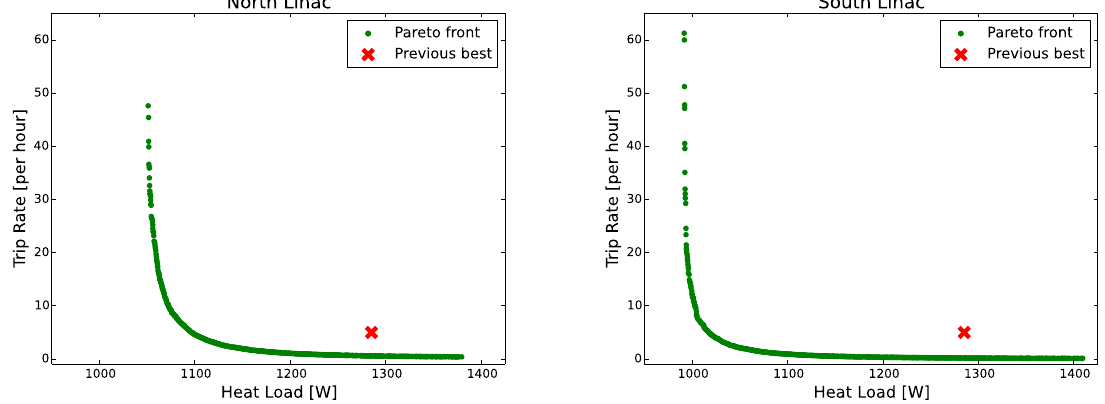
FIG. 7. Pareto-optimal front computed using a GA-based multiobjective optimization with 16000 generations and 512 individuals versus the single-objective GA-based optimization reported in